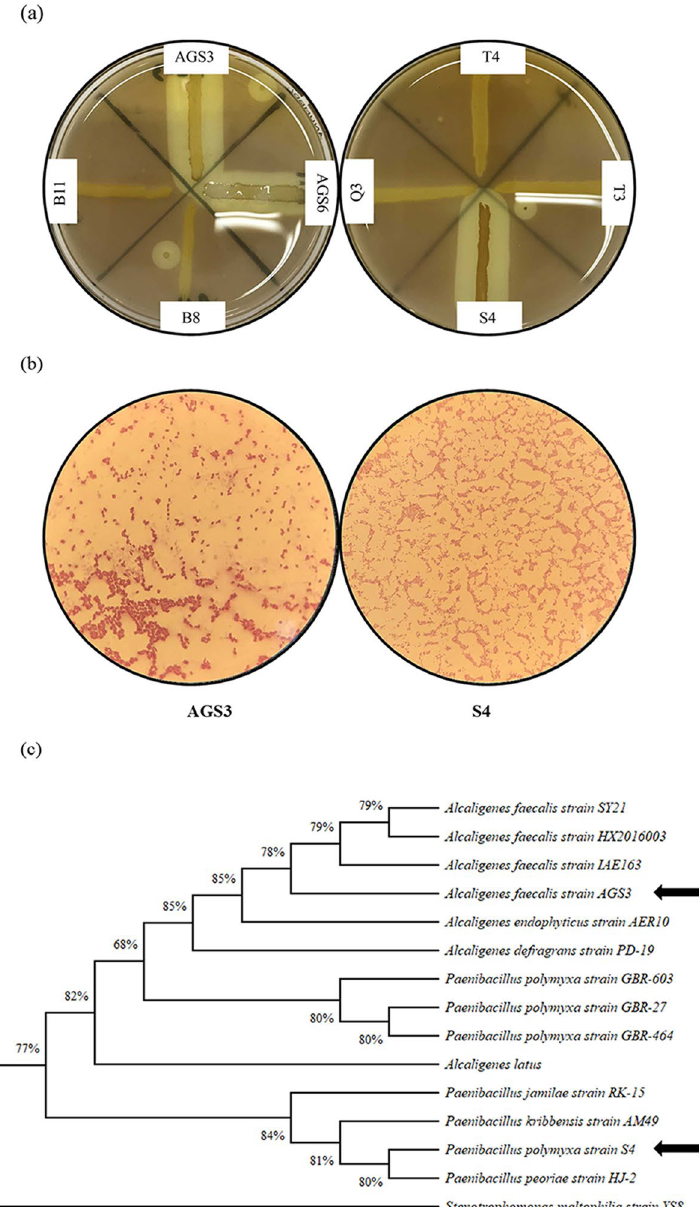
Figure 1. ( a ) Halo area around selected bacterial isolates, AGS3 and S4, showing pectinolytic activity by degradation of polygalacturonic acid (yellow halo areas). ( b ) Microscopic image of AGS3 and S4 bacterial isolates. ( c ) Phylogenetic relationships of A. faecalis isolate AGS3 and P. polymyxa isolate S4. The tree was constructed with MEGA 11 software using the Maximum-likelihood method with 1000